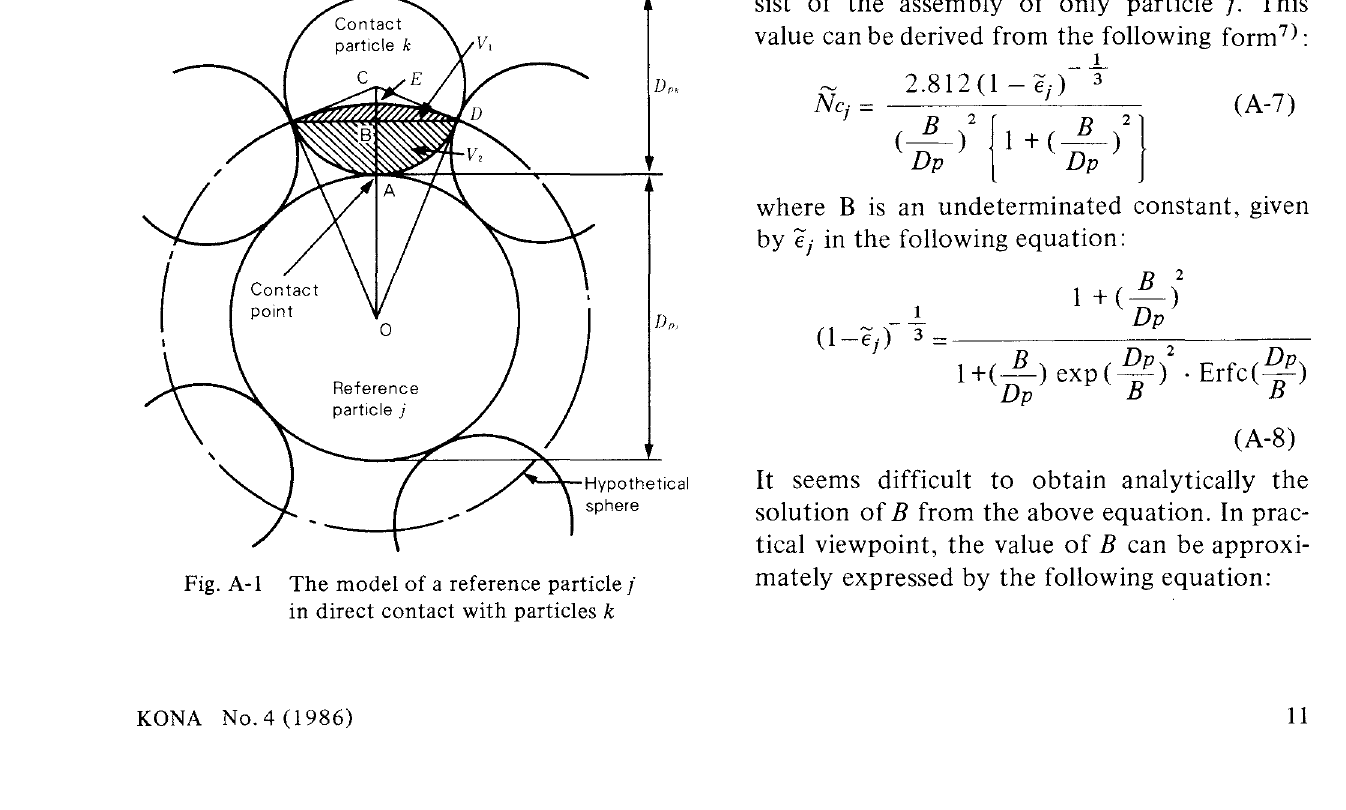
Fig. A-1 The model of a reference particle j in direct contact with particles